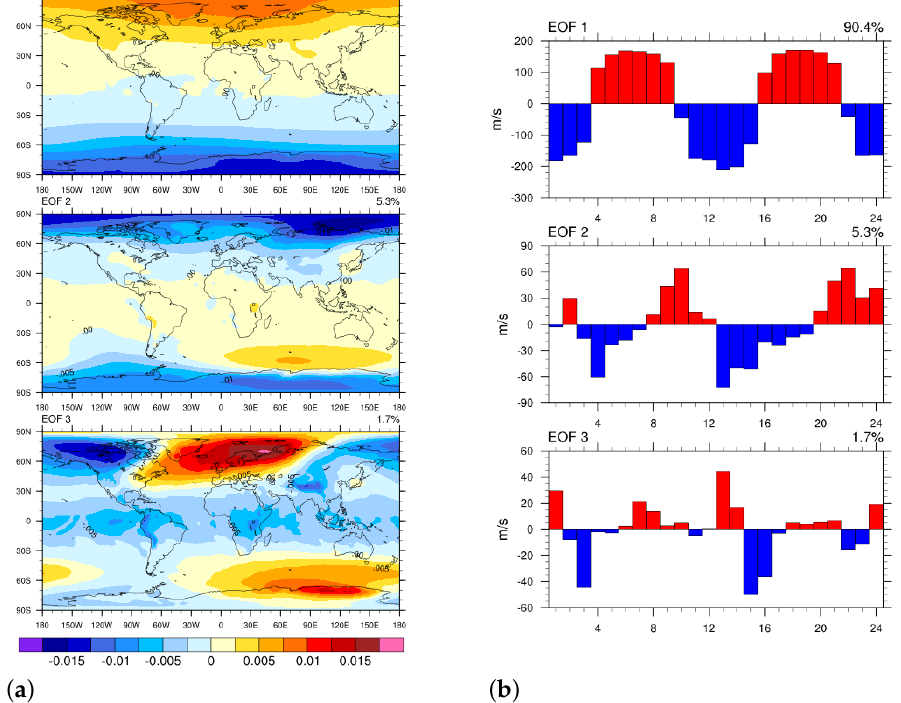
Figure 5. The spatial distribution ( a ) and the time coefficients ( b ) of the first three modes of the MEOF analysis of